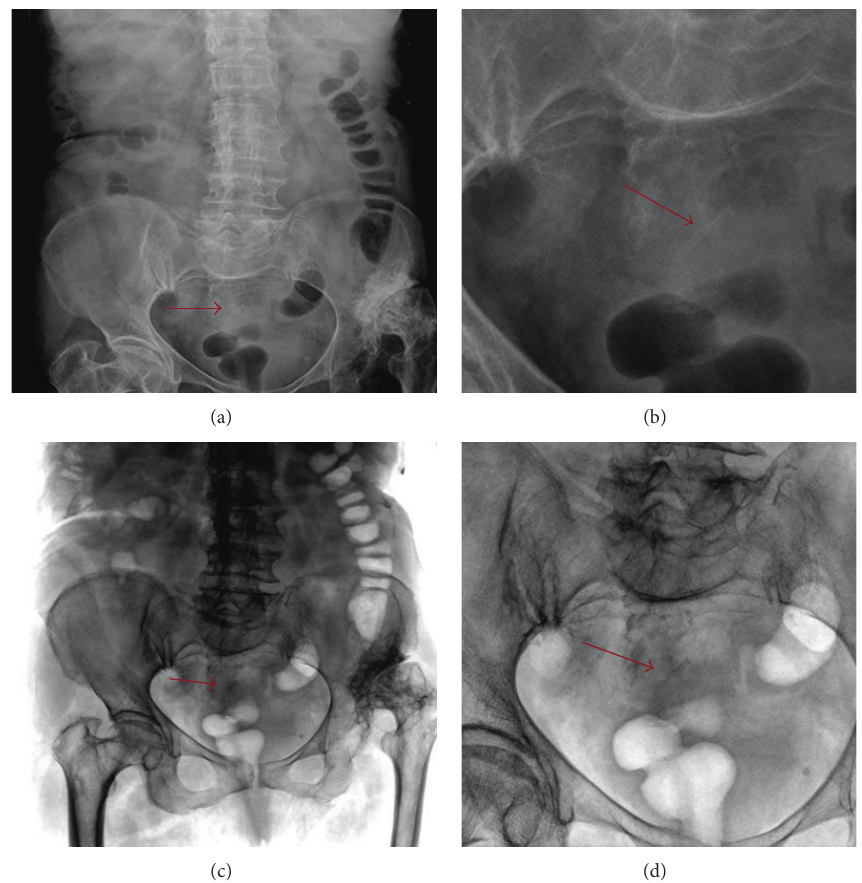
Figure 4: Plain digital radiographs made in January previous hospitalization in another institution and evaluated again in May after window stressing (a, b) and with inversion effect (c, d) showing that the foreign body was already present but not easy to be demonstrated without clinical suspicion due to its low